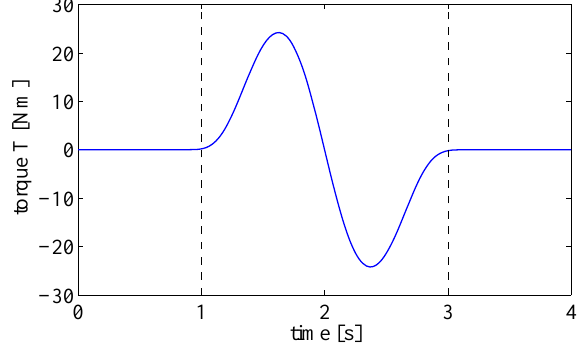
Figure 14. Desired output trajectory y d for rotational manipulator. Figure 15. Rotational manipulator arm: computed control input u